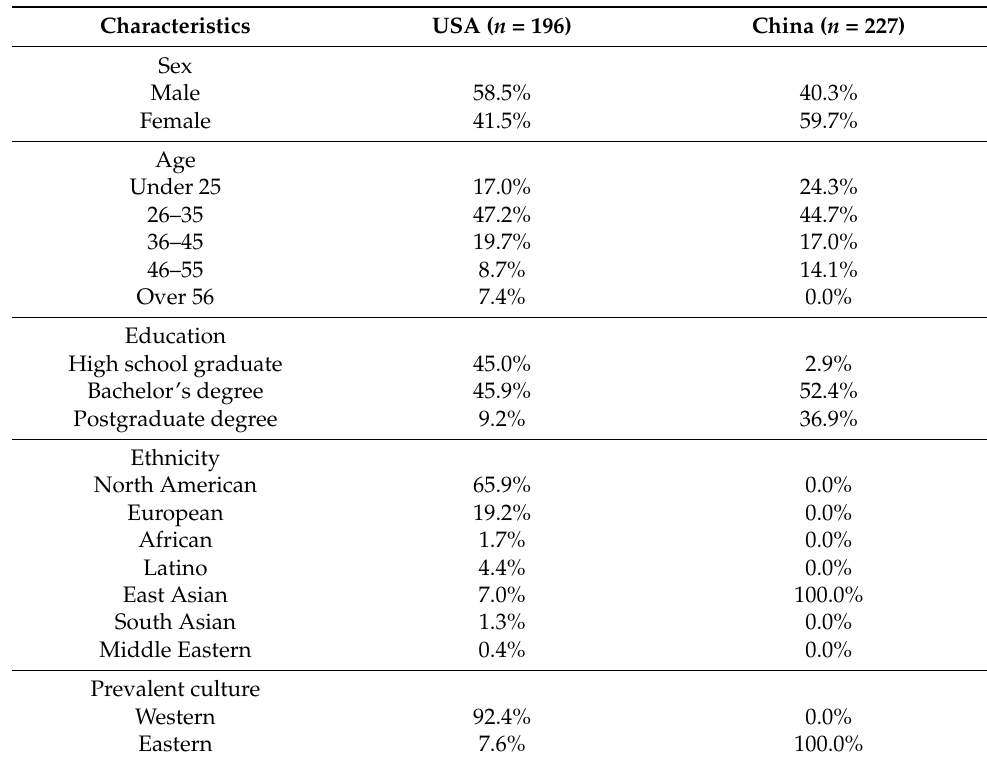
Table 2. Demographic